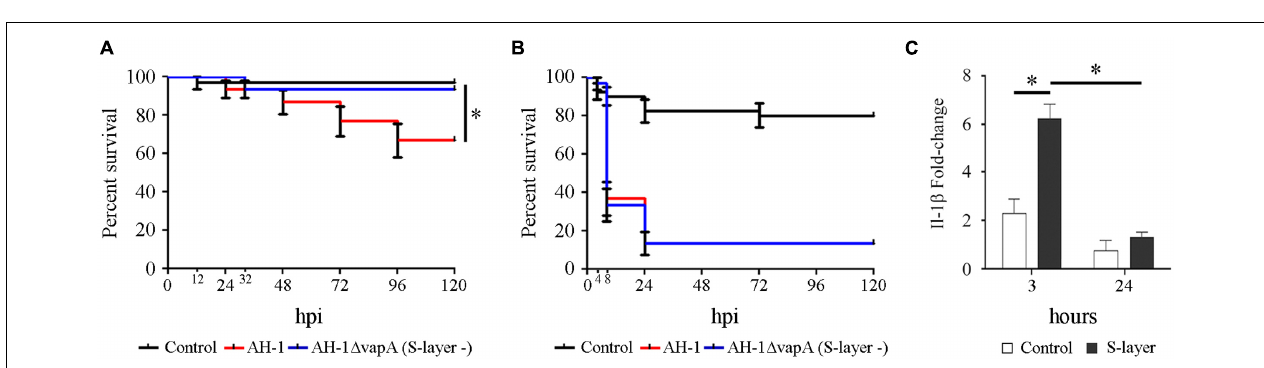
FIGURE 3 | Implications of the O-antigen in the pathogenesis of A. hydrophila . (A) Kaplan–Meier survival curve of healthy larvae infected with A. hydrophila AH-1 wild-type and the mutants AH-1 (cid:49) RmlB (O-antigen negative) and AH-1 (cid:49) wahD (O-antigen negative and altered part of the LPS outer-core). ∗ Significant differences at P = 0.0062. (B) Kaplan–Meier survival curve of injured larvae after infection with the same bacterial suspensions. ∗ Significant differences at P < 0.0001.